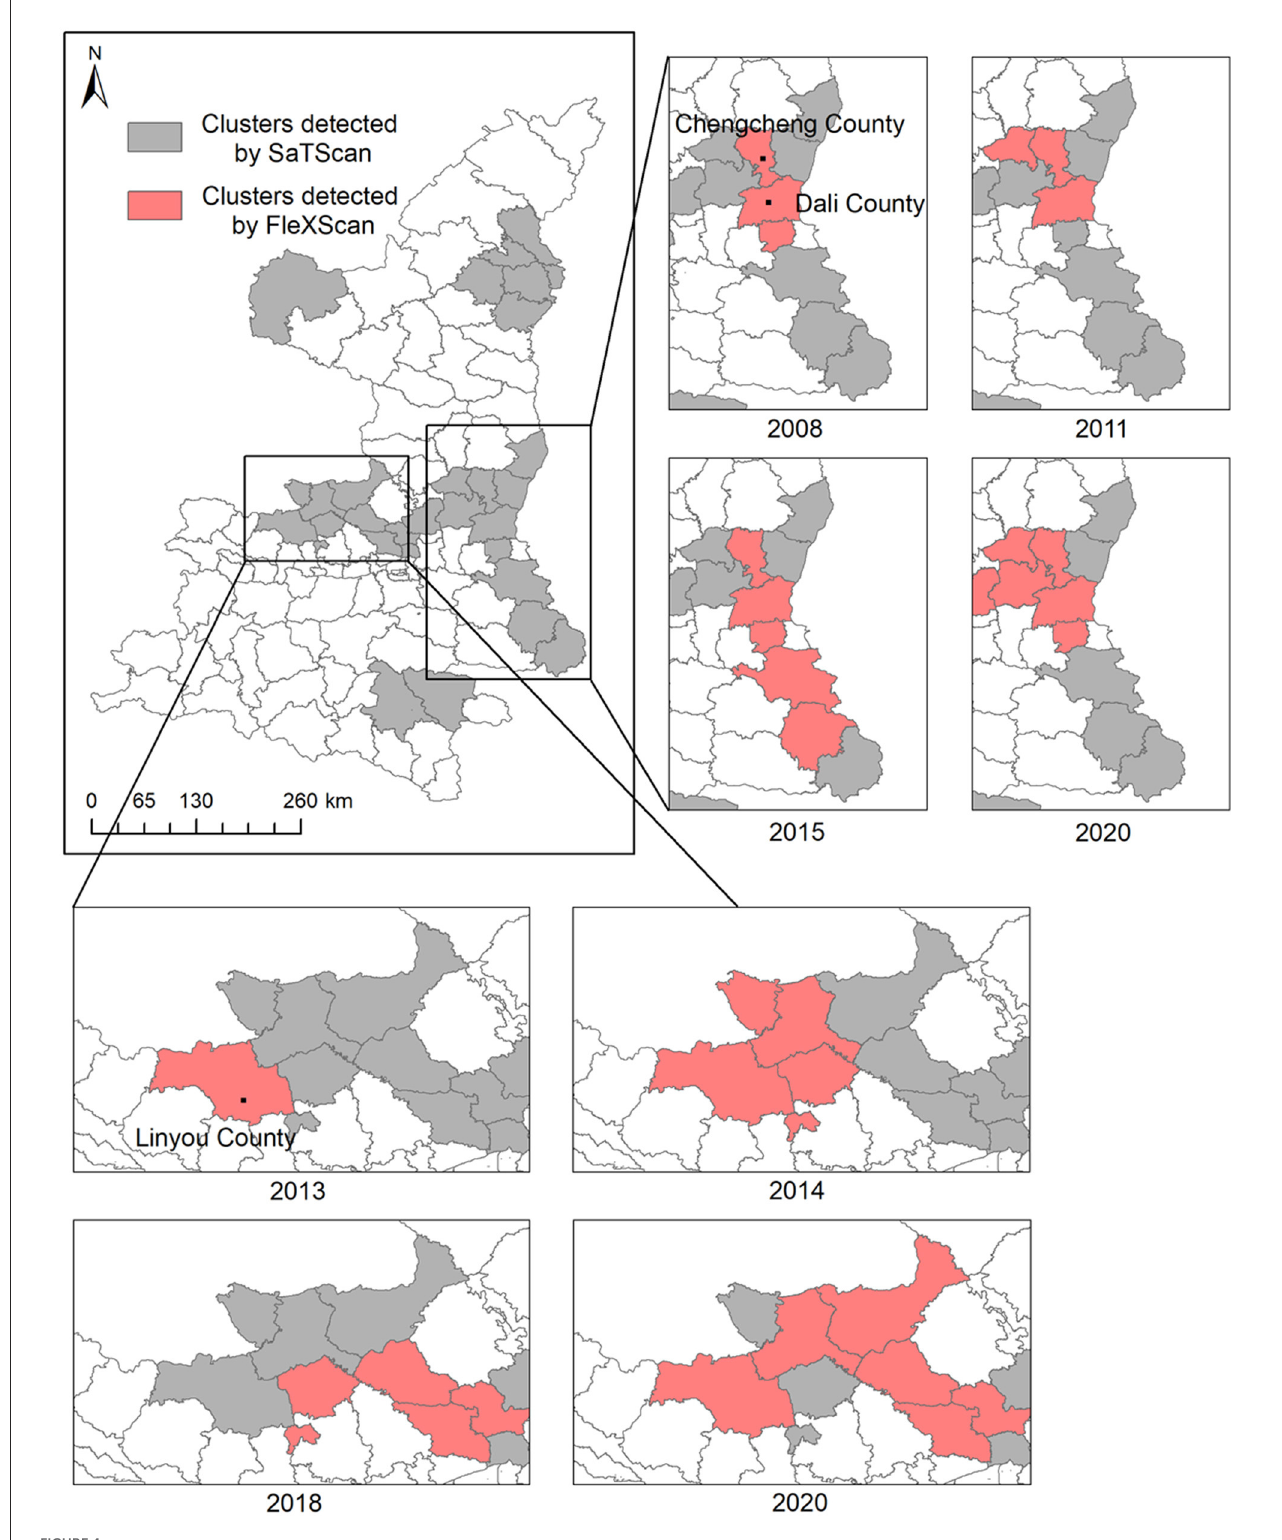
FIGURE4 Spatial clusters detected by FleXScan in two key regions in Shaanxi Province.